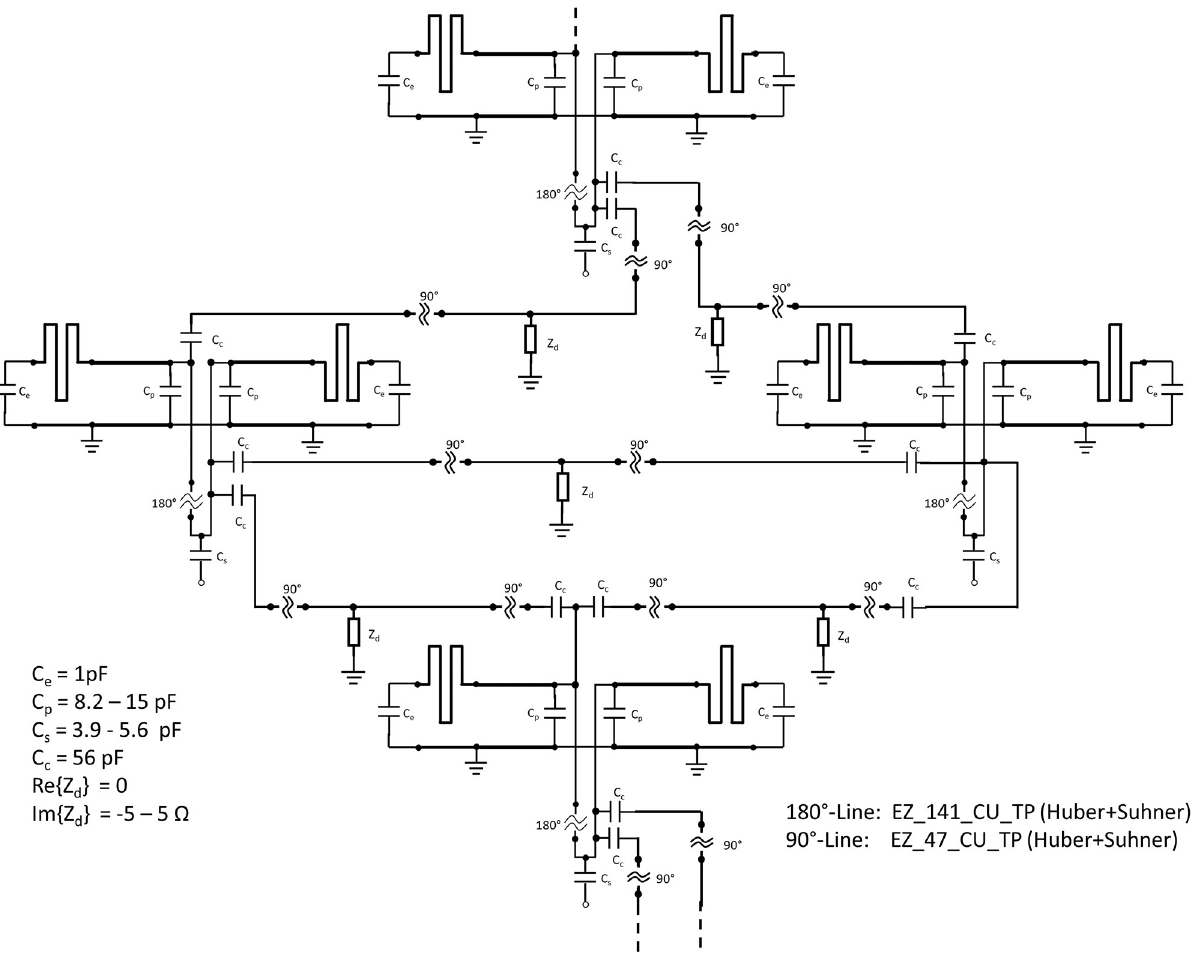
Fig 6. Decoupling network. Schematic of the body array showing four elements including the decoupling network for diagonally placed and head-on elements. C e is used to set the correct current distribution on the element, C p and C s are the parallel and series capacitors of the matching network, and C c and Z d are part of the decoupling network. The 180˚-lines are used for balancing the feed; the 90˚ delay lines are used as part of the decoupling network. These lines are semi-rigid cables from Huber+Suhner AG, Herisau, Switzerland.